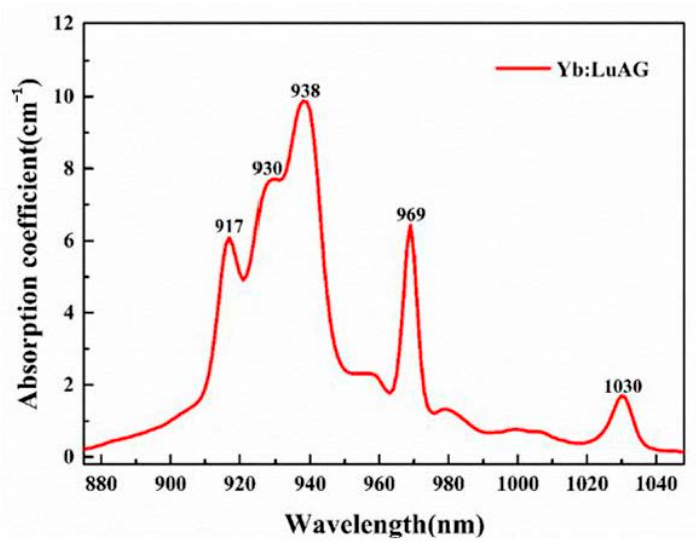
Figure 8. The absorption spectrum of the Yb:LuAG crystal in the wavelength range of 880–1050 nm.